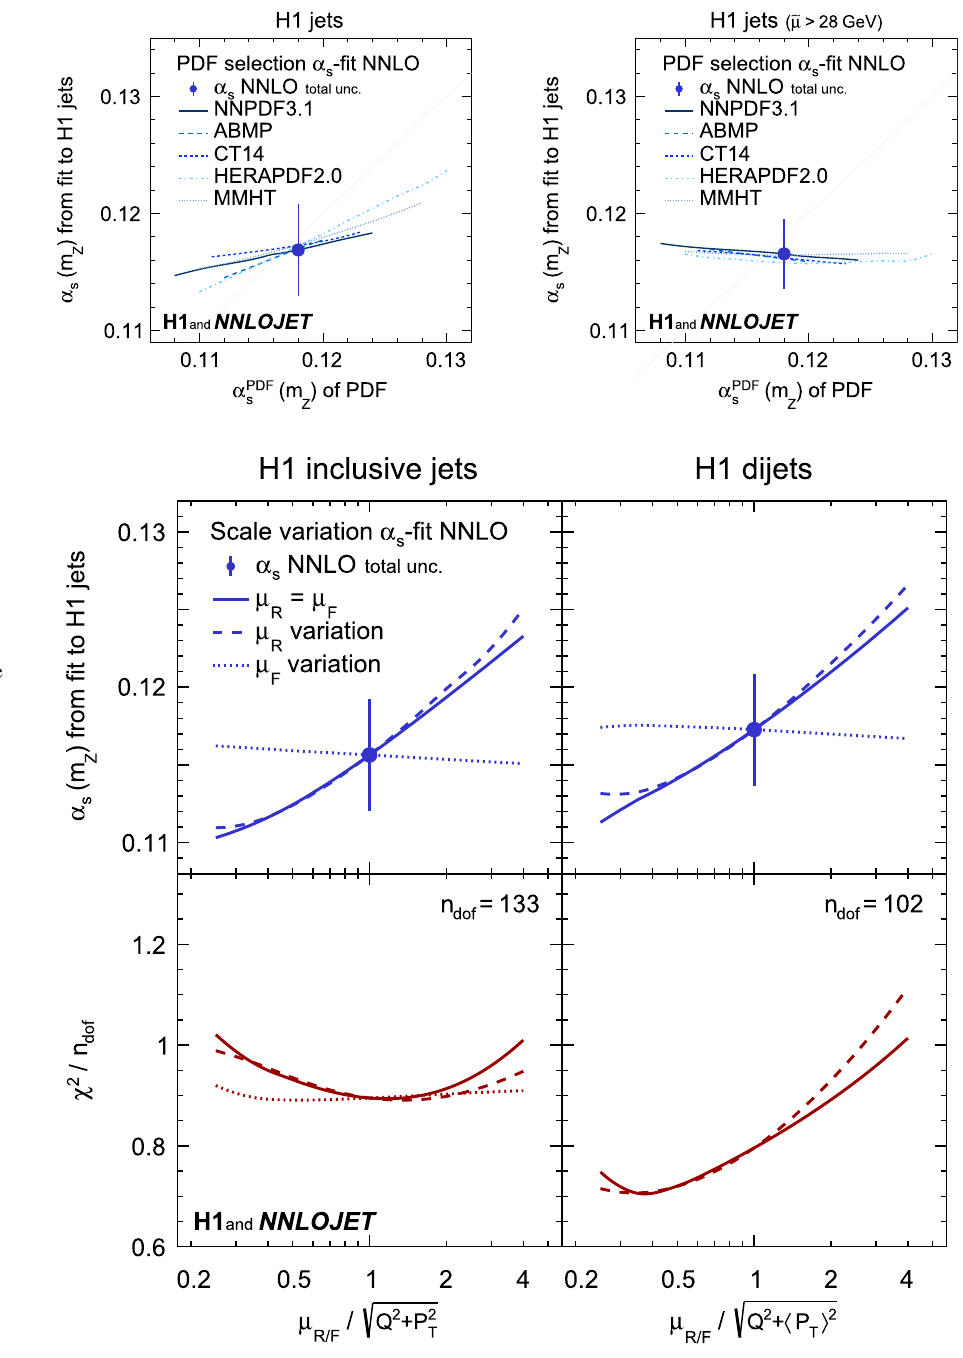
Fig. 8 for fits to inclusive jet and dijet data. The nominal scale = μ 2 = Q 2 + P 2 results in good agreement definition μ 2 R F T